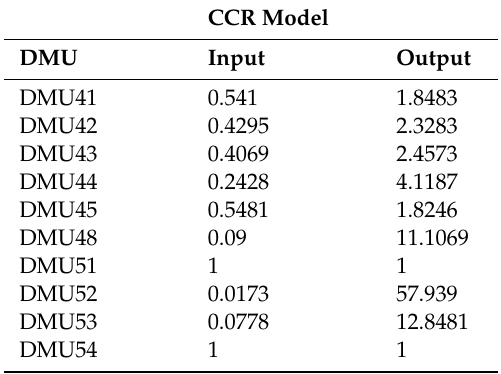
Table 4. In the analysis of outliers, the following production units were found with extreme values: DMU 46, DMU 47, and DMU 50. The DMA 49 production unit could not be included in the DEA analysis as its output was zero, and the investigation could not evaluate its e ff ectiveness. Table 4. CCR method for assessing the e ff ectiveness of beverage